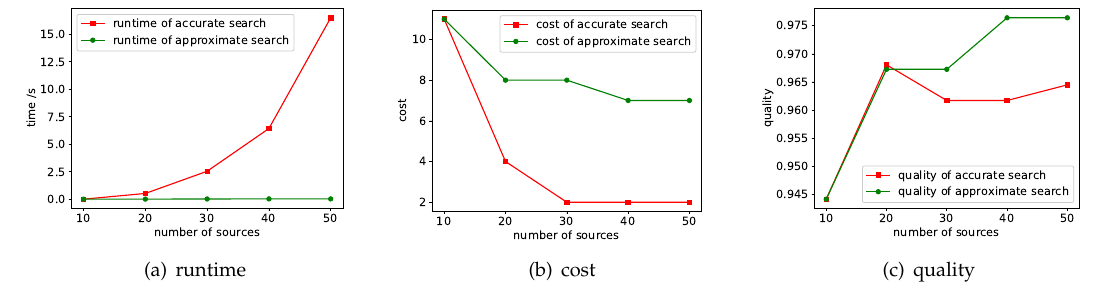
Figure 5. Experimental results when varying | S |